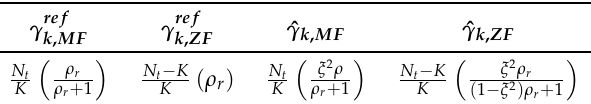
Table 2. Summary of approximated